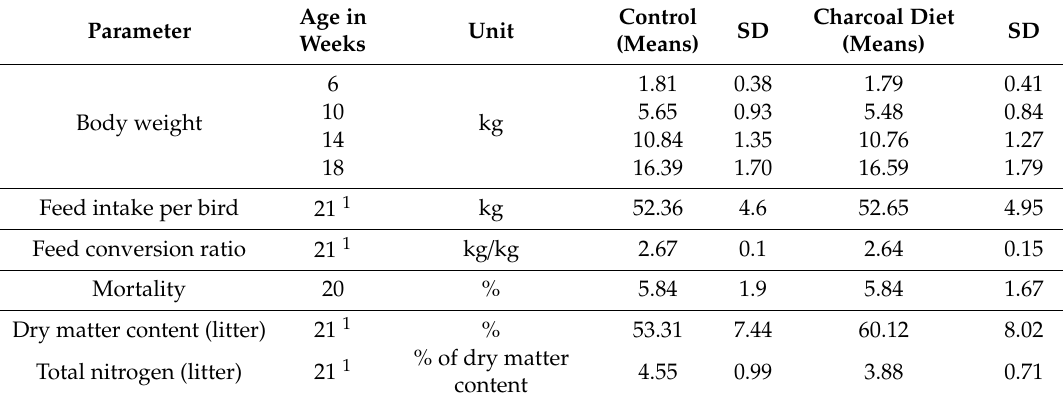
Table 5. Performance results of Experiment 1; means and standard deviation (SD) of the different parameters of the BUT6 turkey toms; of body weight ( n = 3 farms, n = 6 batches, n = 958 turkeys (charcoal